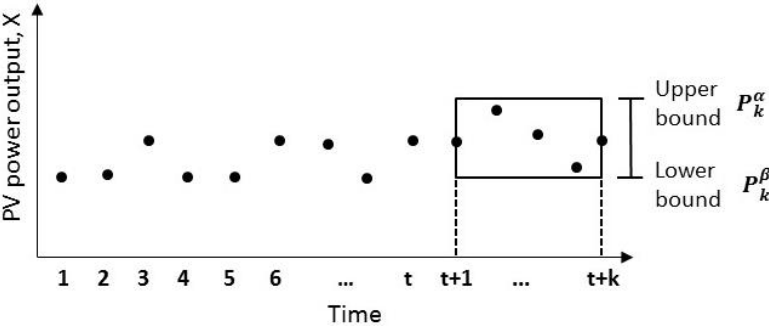
Figure 2. 2D-interval forecast for PV power time series.